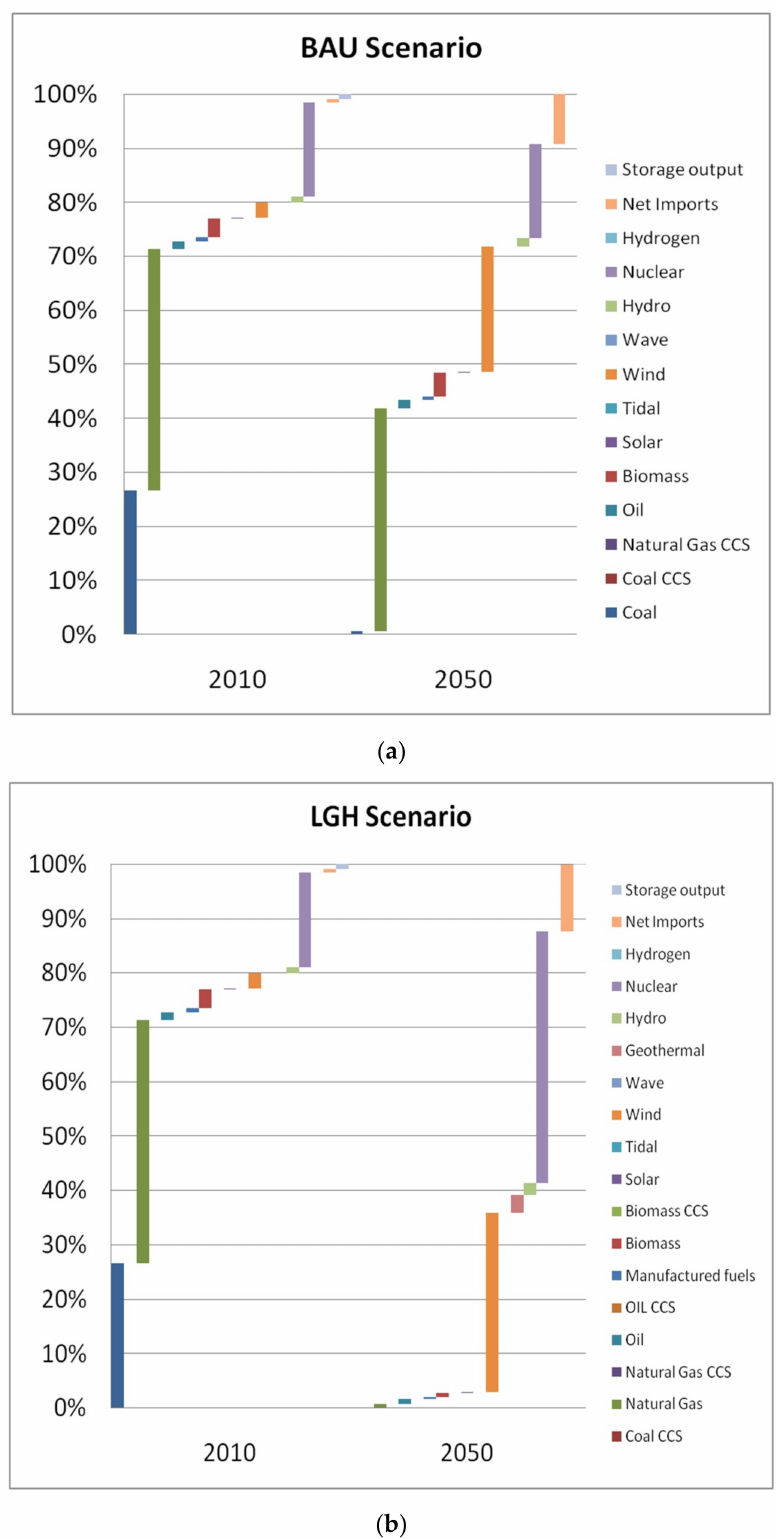
Figure 8. ( a ) Fuel source for generating electricity in the BAU case; ( b ) fuel source for generating electricity in the LGH case. (Note that legends and colours in Figure 8 are aligned in sequential order for ease of